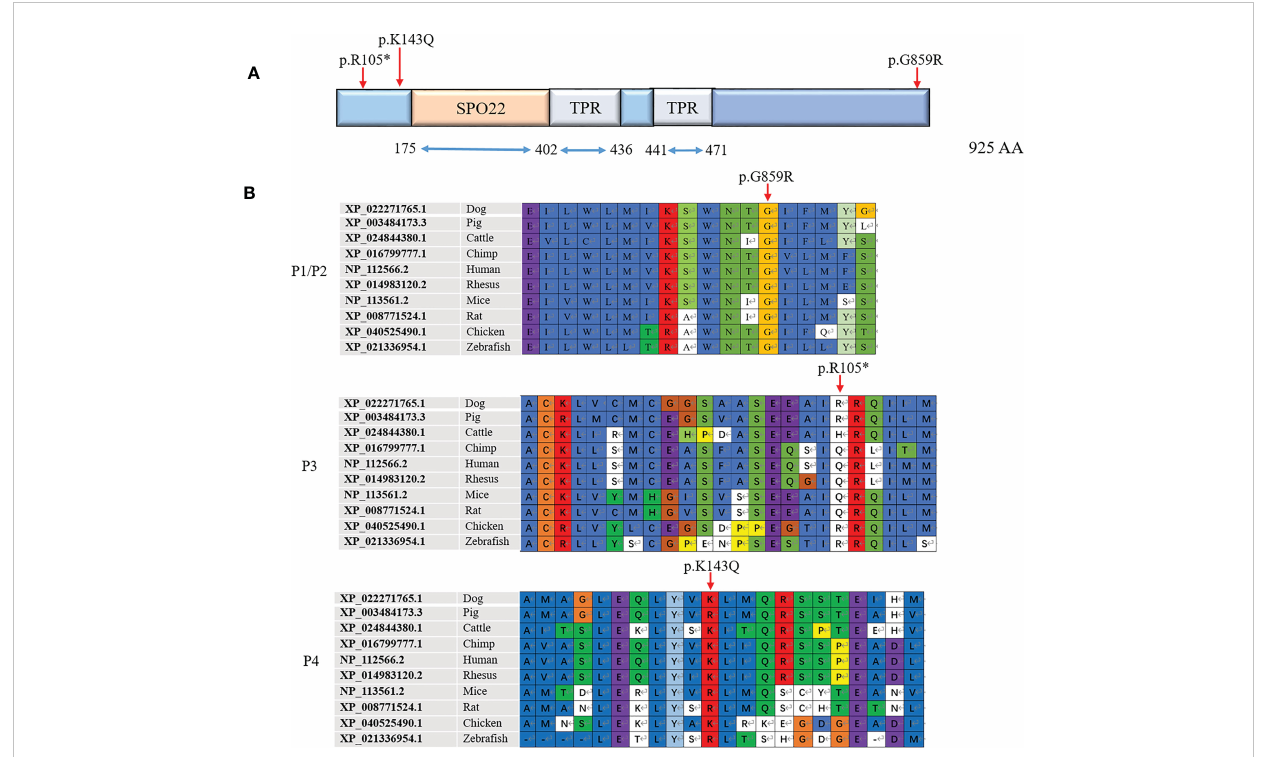
FIGURE 4 Three novel mutations identi fi ed in the TEX11 gene. (A) Predicted TEX11 domains with a SPO22 motif (amino acid positions 175-402) and multiple TPR-containing regions. The mutations found were shown under the predicted protein domains for TEX11. (B) Amino acid sequence alignment of TEX11 from different species. The red arrow indicates the mutated amino acid. TEX11, testis expressed 11; SPO22, sporulation domain; TPR, tetratricopepetide repeat; WT, wild type; AA, amino